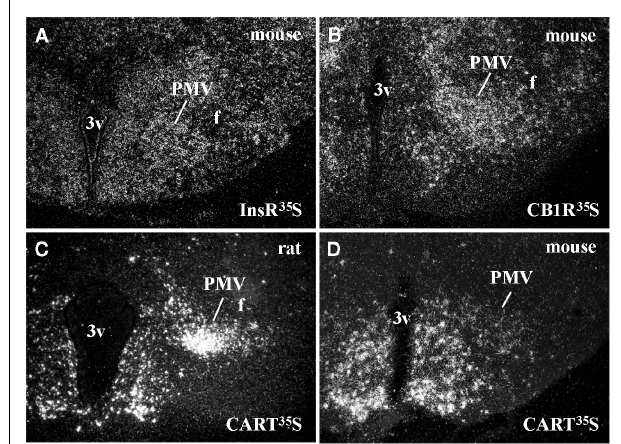
FIGURE 1 | Neurochemical characteristics of the ventral premammillary nucleus (PMV). (A,B) Darkfield photomicrographs demonstrating the distribution of insulin receptor (InsR) mRNA (A) and cannabinoid receptor type 1 (CB1R) mRNA (B) in the mouse PMV. (C,D) Darkfield photomicrographs demonstrating the distribution of cocaine and amphetamine regulated transcript (CART) mRNA in the rat (C) and in the mouse (D) PMV. Note the abundance of CART mRNA in the PMV of rats compared to